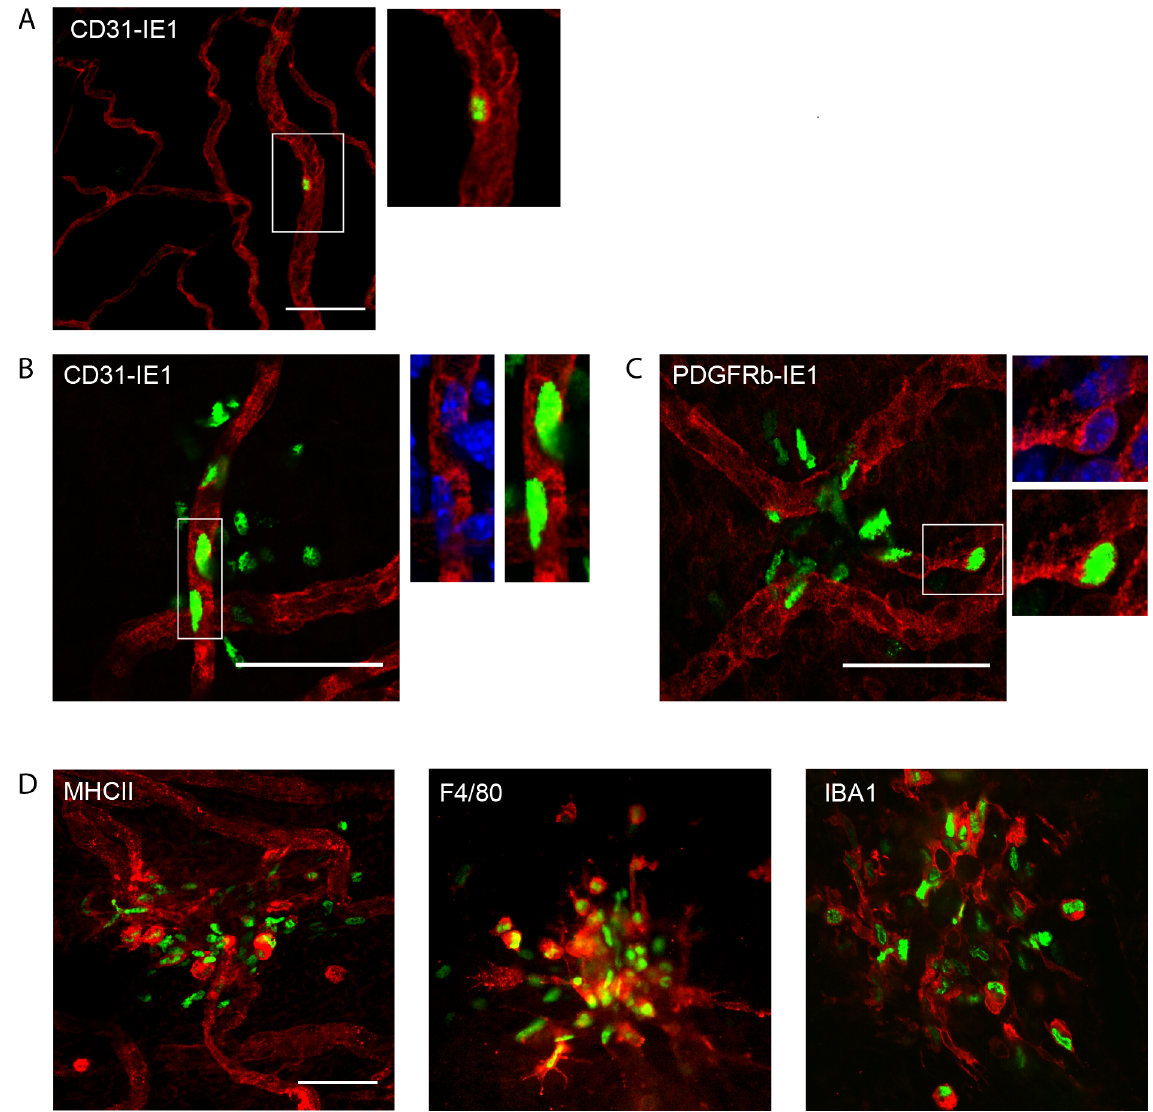
Fig 5. Characterisation of cells infected by MCMV within the iris. (A) Wholemounts of the iris were prepared at 24 hr pi and stained with antibodies to CD31 (red) and the IE1 viral antigen (green). Iris whole-mounts at day 2 pi were stained with anti-IE1 (green) and (B) anti-CD31 or (C) anti-PDGFR β antibodies. Blue = DAPI nuclear stain. (D) Wholemounts of the iris at day 5 pi were stained with anti-IE1 (green) along with antibodies directed against the indicated cell surface markers (red). Anti-IE1 detects a nuclear antigen. Scale bar: 50 μm. Results are representative of at least 3 independent experiments with n (cid:21)